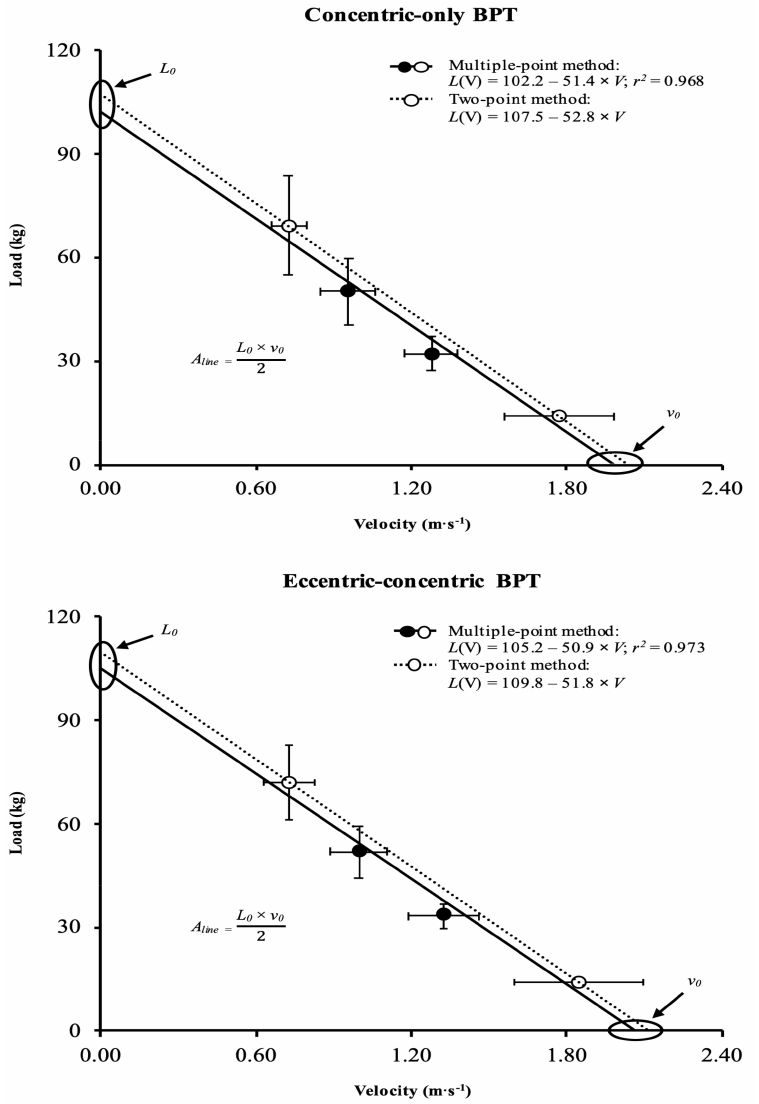
Figure 1. Load–velocity relationship obtained from the data averaged across the subjects modelled by the multiple-point (filled circles and continuous line) and two-point (open circles and dotted line) methods during the concentric-only (upper panel) and eccentric–concentric (lower panel) prone bench pull (PBP) variants. The regression equations and Pearson’s multivariate coefficients of determination ( r 2 ) are depicted. L 0 , load–axis intercept; v 0 , velocity–axis intercept; A line , area under the load–velocity relationship